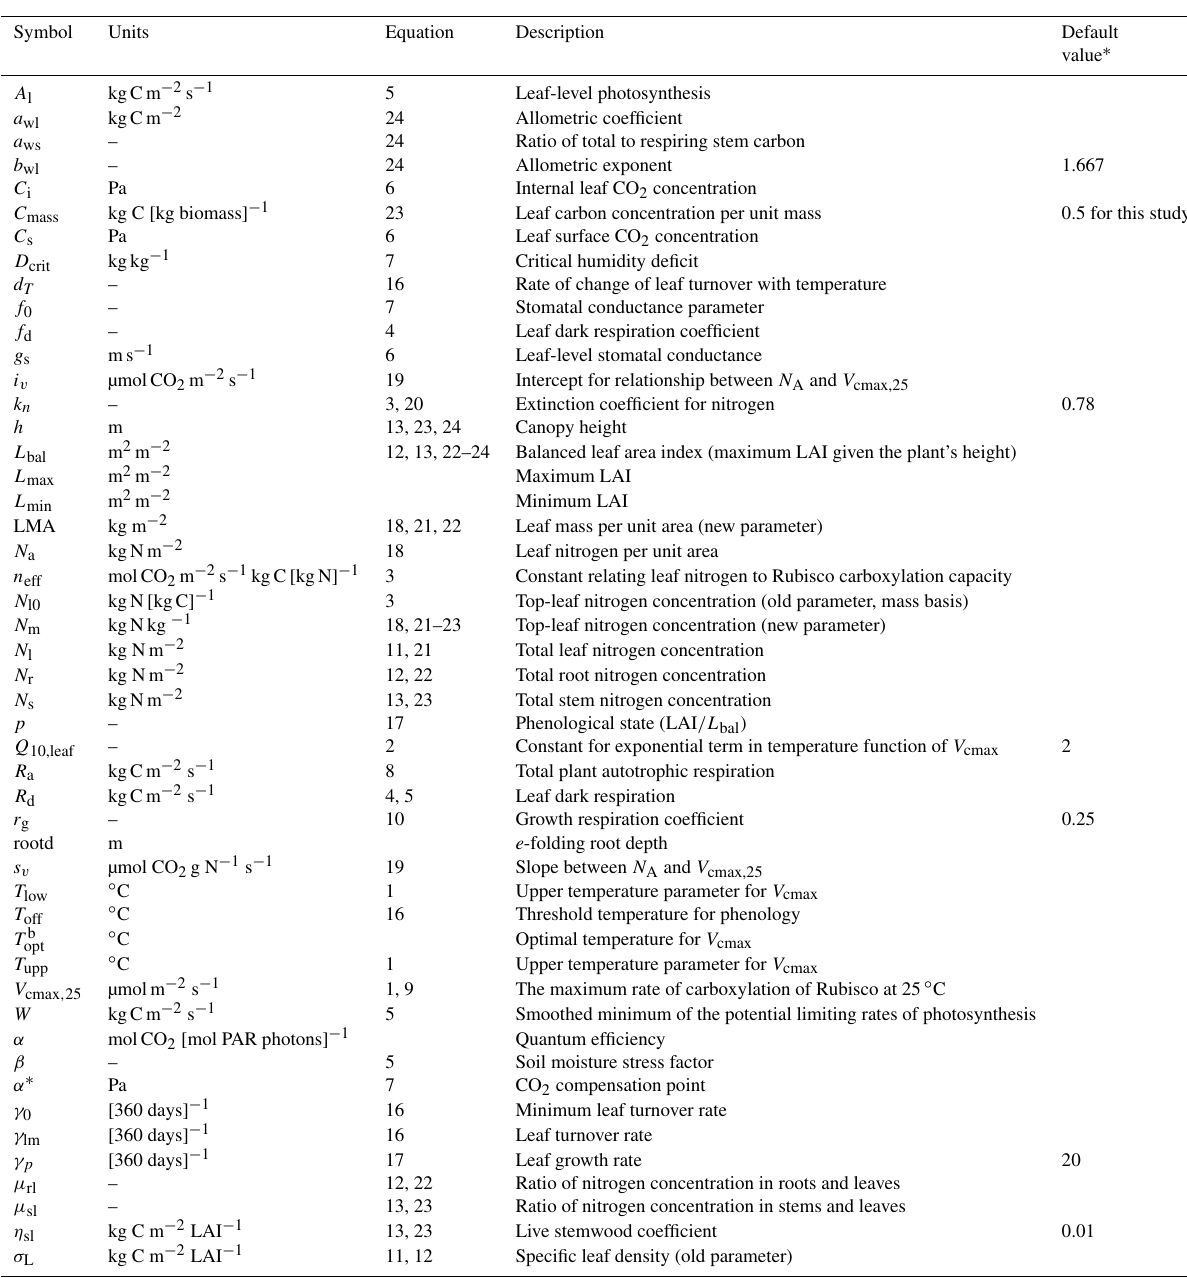
Table A1. List of parameters and symbols in the